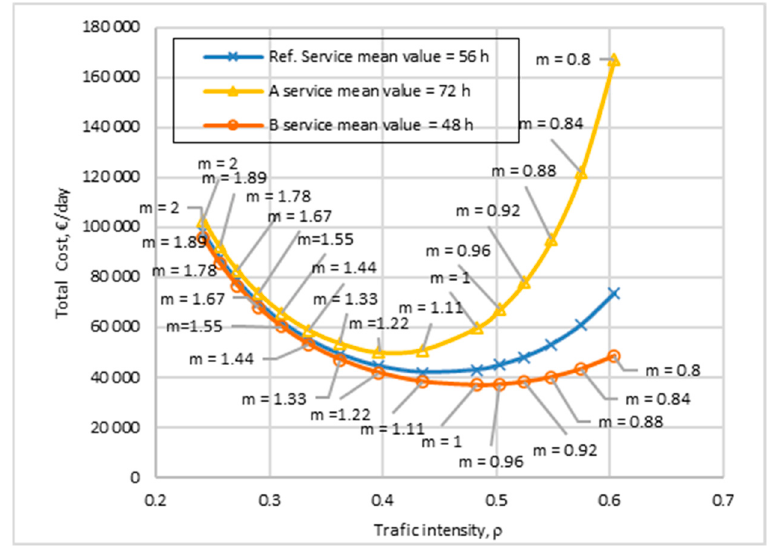
Figure 11. Total cost as a function of traffic intensity, conditional on service time.